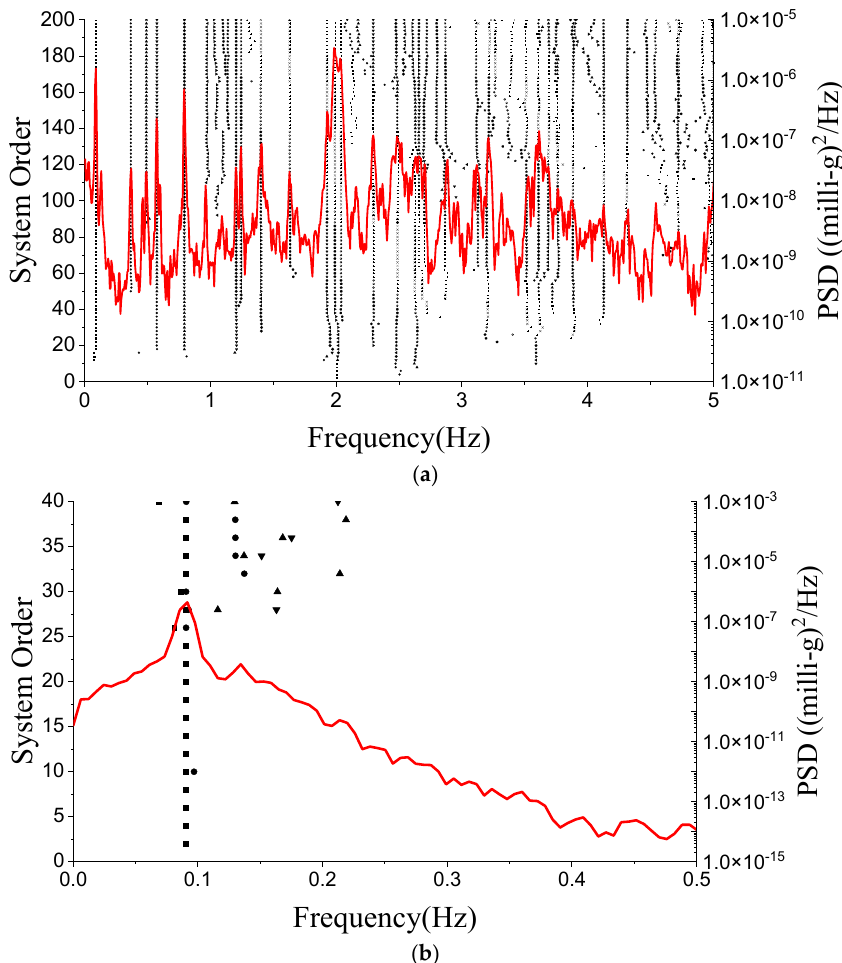
Figure 15. Stabilization diagram of original and decomposed acceleration response for the Canton Tower. ( a ) Original data; ( b ) IMF10.